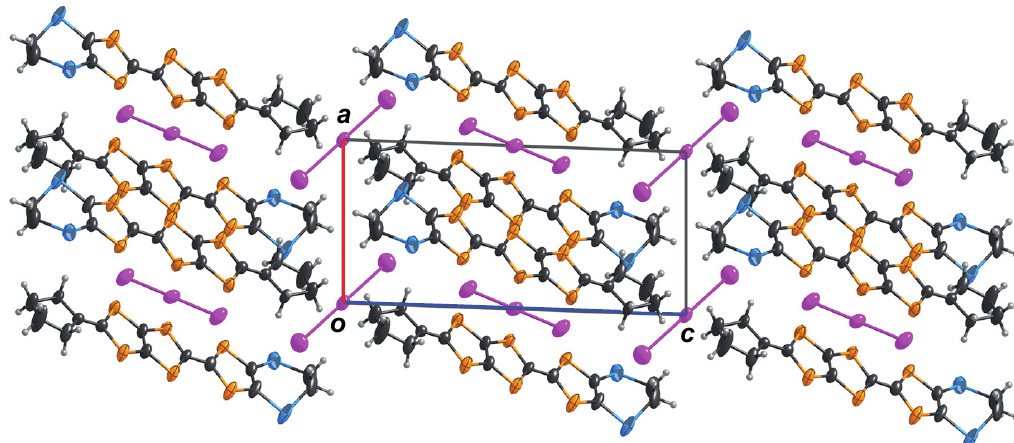
Figure 19. Crystal structure of 7 viewed along the b